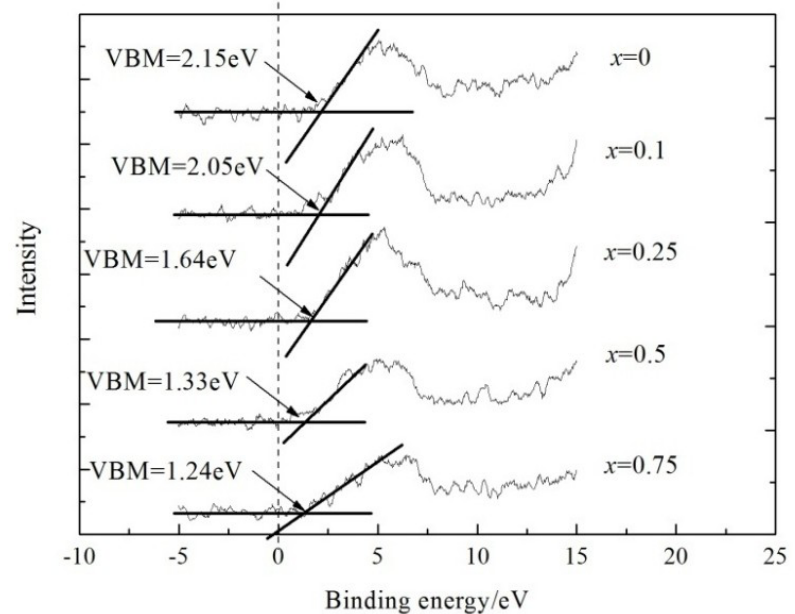
Sr TiO 1− x x 3+δ